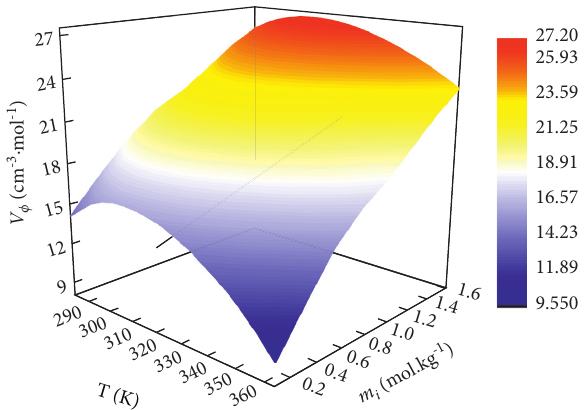
Figure 3: Apparent molar volumes of YCl 3 aqueous solutions against temperature and